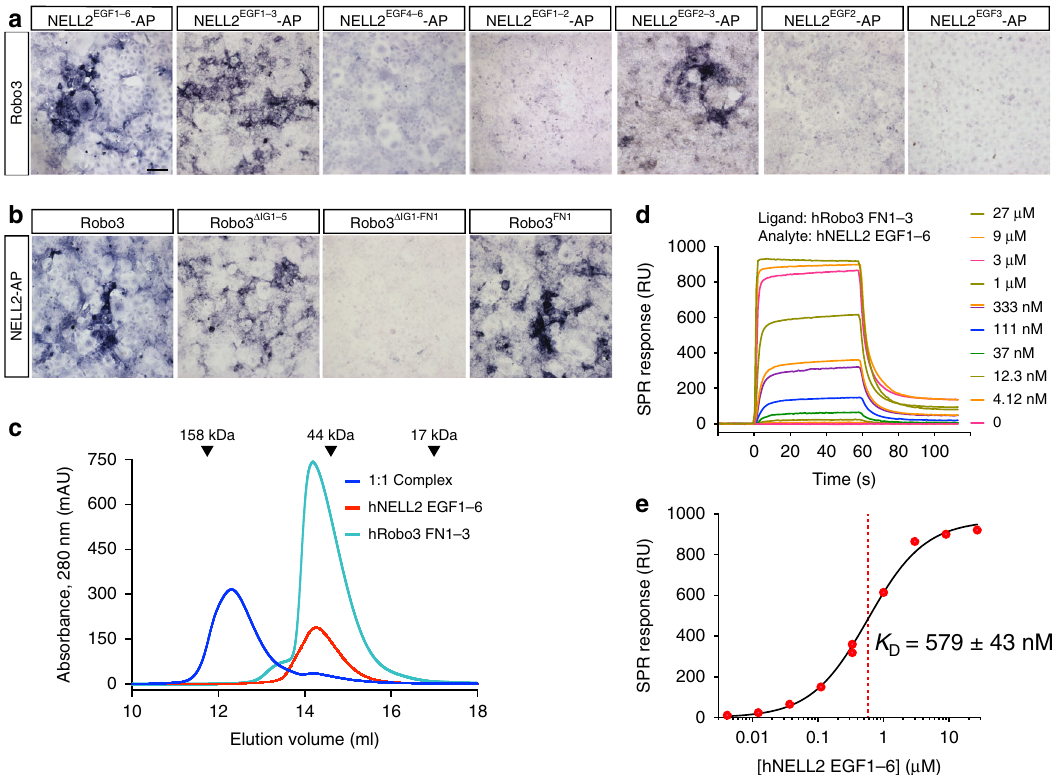
Fig. 2 NELL2 EGF2 – 3 bind Robo3 FN1 to mediate complex formation. a, b Domains mediating NELL2 – Robo3 interactions were mapped using a COS-7- based AP-fusion protein binding assay. NELL2 EGF2 and EGF3 together are necessary and suf fi cient for binding to Robo3 ( a ). Robo3 FN1 is necessary and suf fi cient for NELL2 binding ( b ). c Size-exclusion chromatography of the hNELL2 EGF1 – 6 and hRobo3 FN1 – 3 complex. hNELL2 EGF1 – 6, hRobo3 FN1 – 3, and a molar 1:1 mixed complex samples were injected in a Superdex 200 Increase 10/300 column, and the elution pro fi le was recorded by following absorbance at 280 nm with a pathlength of 0.2 cm. Dark blue: hNELL2 EGF1 – 6 + hRobo3 FN1 – 3 complex sample; Cyan: hRobo3 FN1 – 3; and Red: hNELL2 EGF1 – 6. AU: Absorbance units. SPR sensorgrams ( d ) and equilibrium response fi tting to a Langmuir 1:1 binding model ( e ) for biotinylated hRobo3 FN1 – 3 as ligand on an NLC/neutravidin chip with hNELL2 EGF1 – 6 as the analyte (mobile phase) collected on a ProteOn XPR36. Legend on the right in ( d ) refers to concentration of the analyte injected on the SPR chip. Black curve in ( e ) is the Langmuir model fi t to response values measured at equilibrium. ± refers to standard error of the fi t. Scale bar, 100 μ m, ( a , b